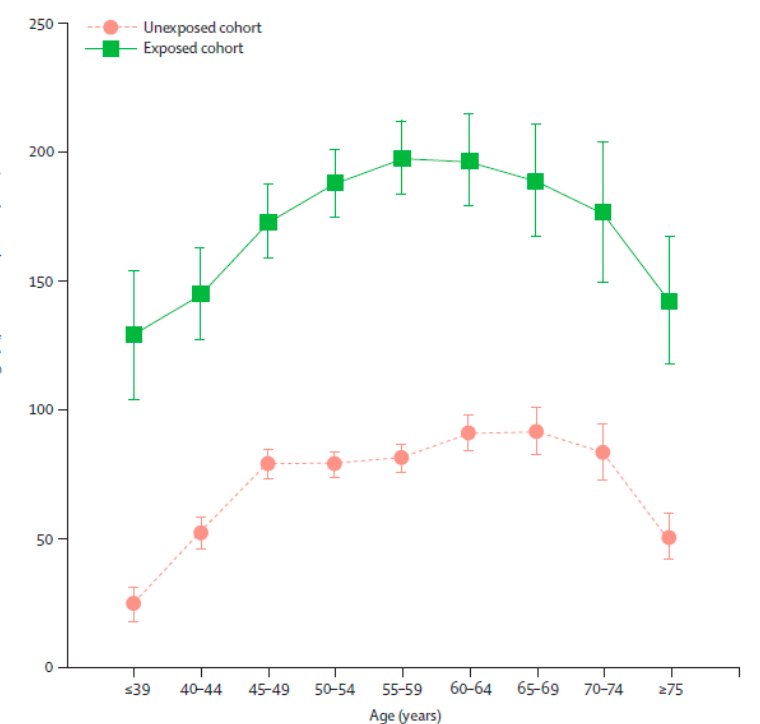
Figure 2. Age-specific rates of first urinary incontinence operation in women in the exposed and unexposed cohorts. Age-specific rates are shown with 95% CIs. Age intervals show attained age during follow-up period. Reprinted from The Lancet , 370, Altman et al., Hysterectomy and risk of stress-urinary-incontinence surgery: nationwide cohort study, 1494–1499, ©2007, with permission from Elsevier [47].